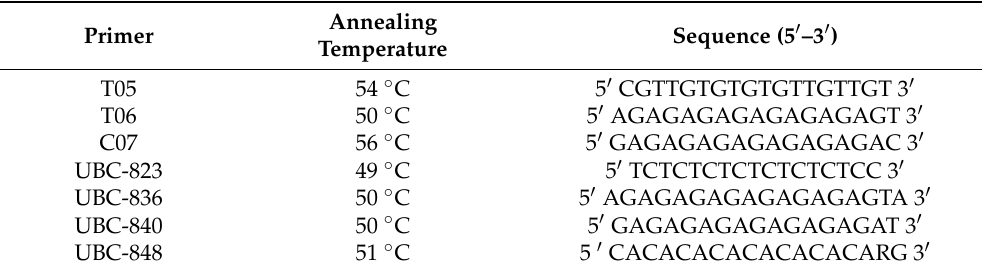
Table 5. ISSR primers used for genetic integrity assessment of V. planifolia regenerants from cryo- procedures and in vitro-derived